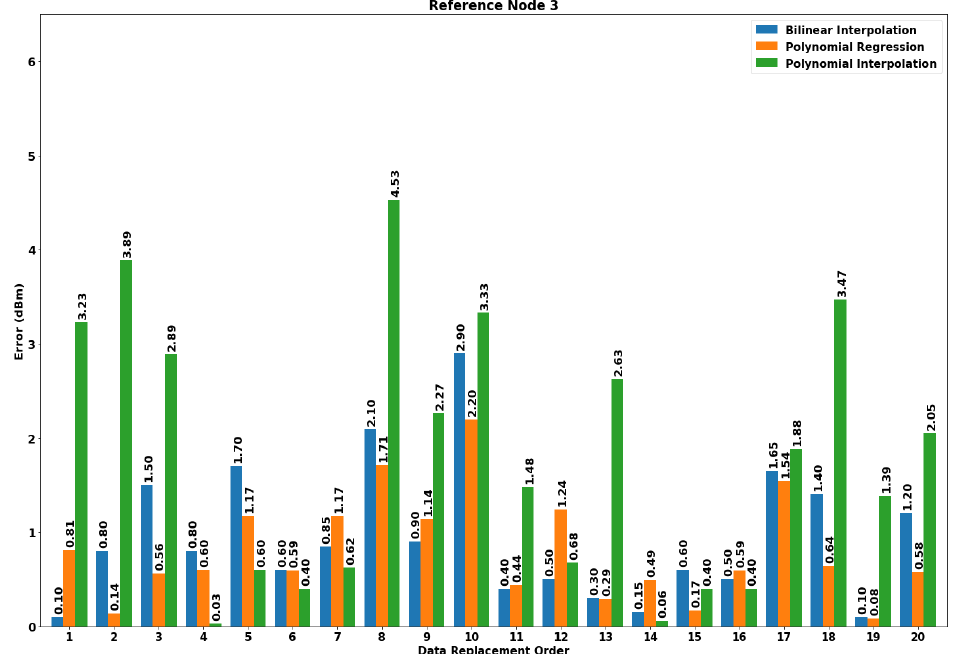
Figure 19. RSSI values error for reference node